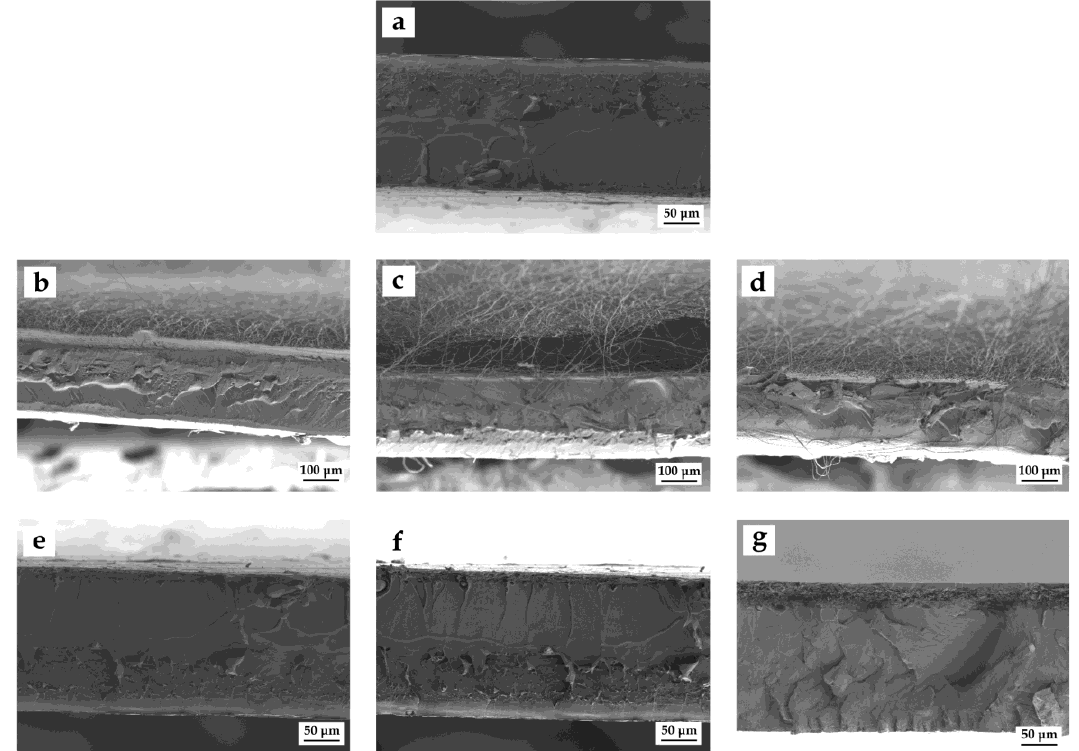
Figure 2. Field emission scanning electron microscopy (FESEM) micrographs of the gallic acid (GA)-containing polylactide (PLA) films of: ( a ) monolayer; ( b ) bilayer 1 h; ( c ) bilayer 2 h; ( d ) bilayer 3 h; ( e ) multilayer 1 h; ( f ) multilayer 2 h; ( g ) multilayer 3 h.